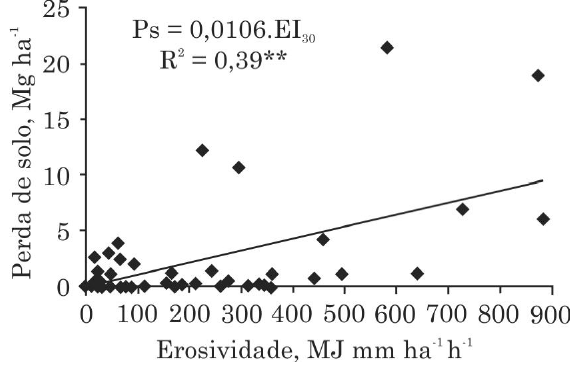
Figura 1. Dispersão e ajuste dos dados entre perda de solo e erosividade (EI 30 )no período2006-2011, considerando 114 eventos individuais de chuvas erosivas. ** Estatisticamente significativo a 1